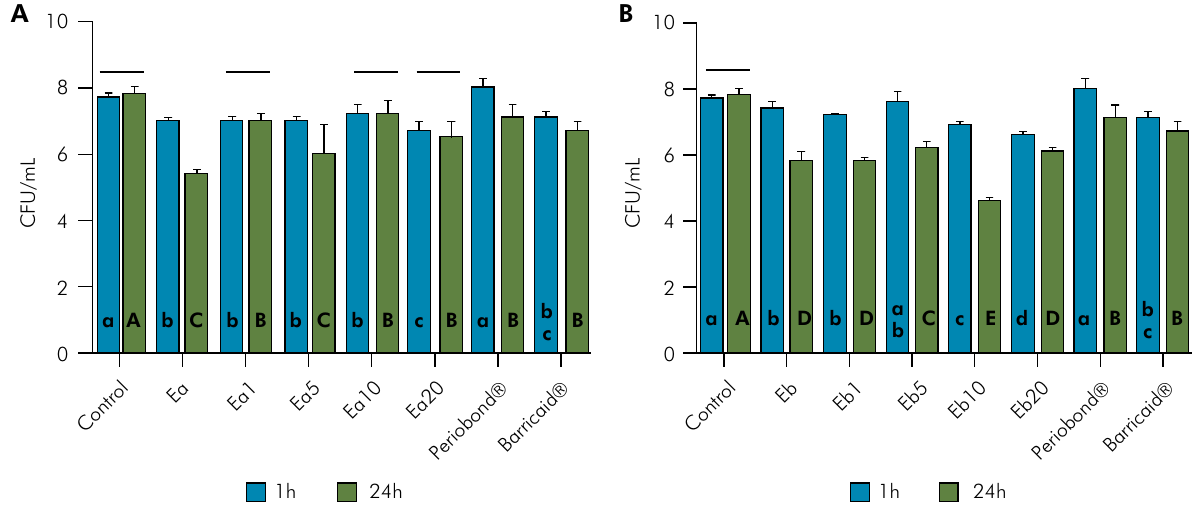
Figure 1. Modified direct contact test against S. aureus at 1 and 24 hours. For each material (Ea or Eb), different lowercase letters indicate significant differences for CFU/mL at 1 h incubation (p < 0.05); different uppercase letters indicate significant differences for CFU/mL at 24 h incubation (p < 0.05); columns under the same horizontal line indicate no differences within the incubation time for each group.